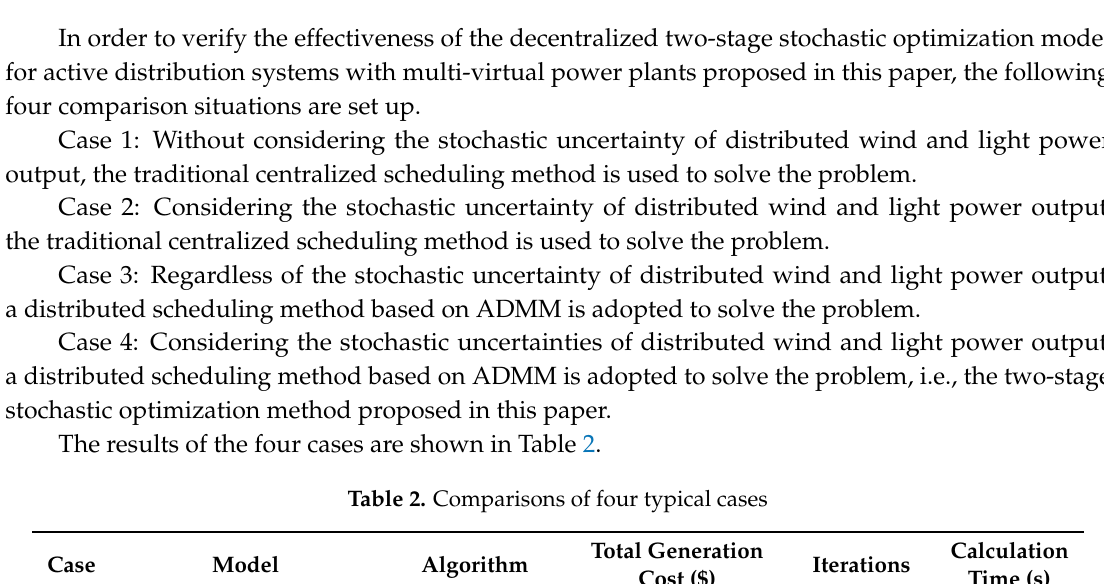
Figure 8. Convergence of total generation cost.